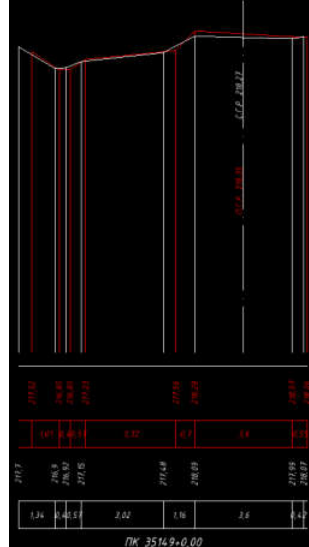
Figure 10. The example of a cross profile